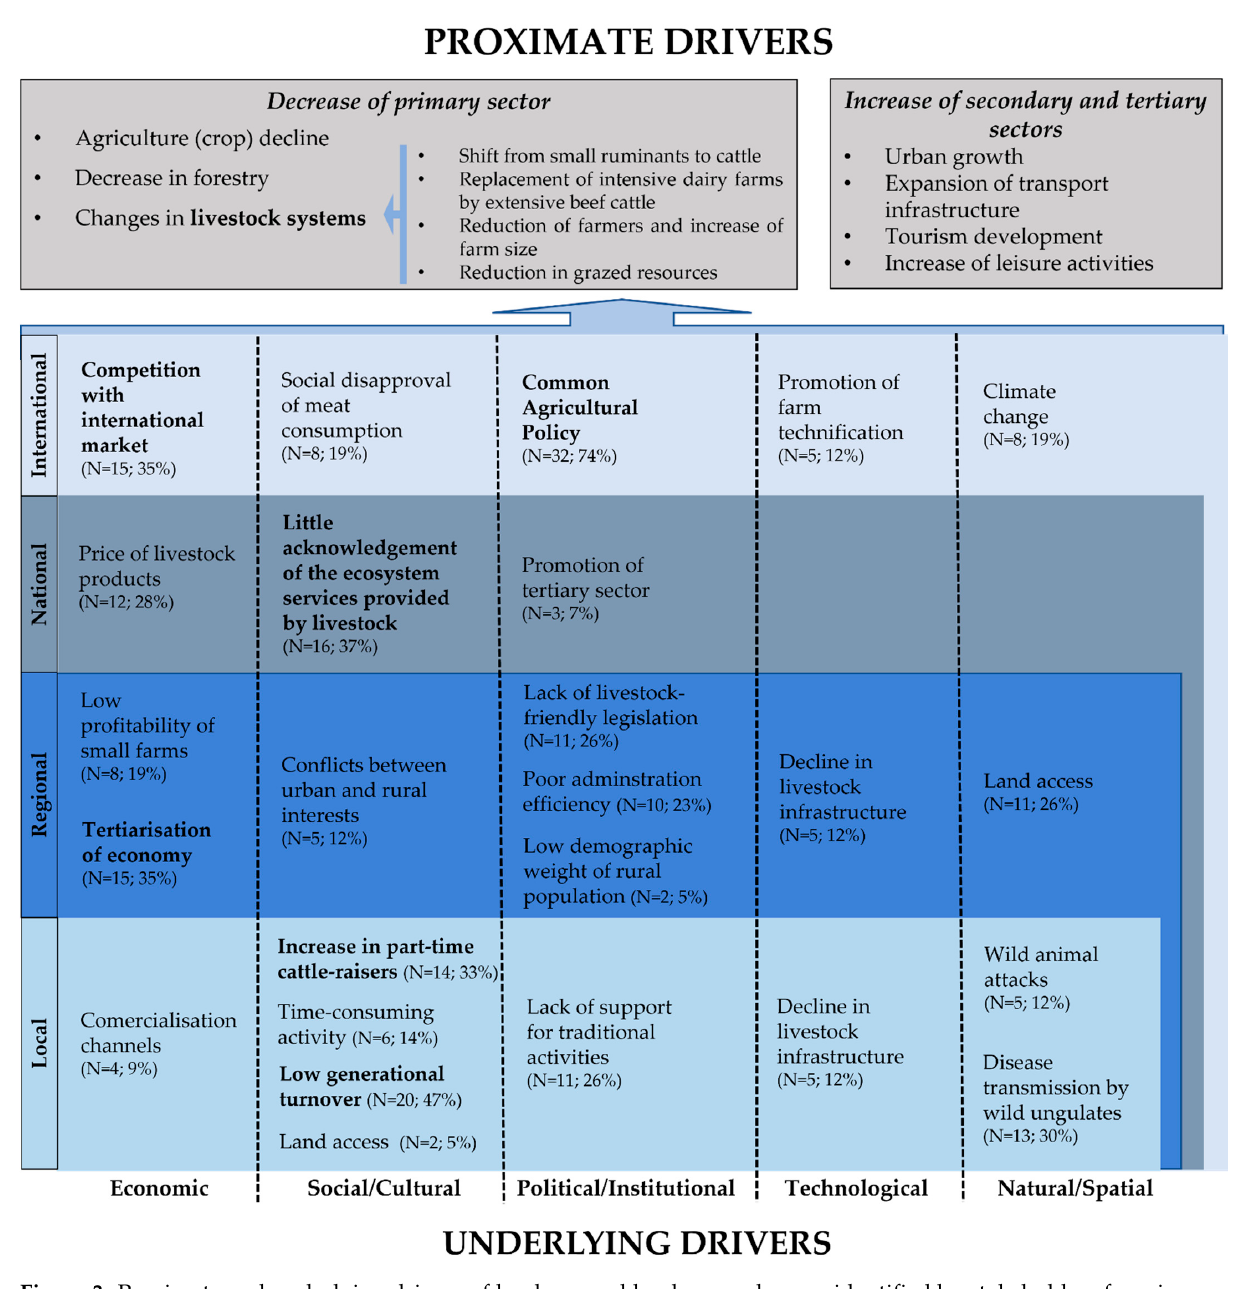
Figure 3. Proximate and underlying drivers of land use and land cover changes identified by stakeholders focusing on livestock-related factors in two study areas of Madrid region. The proximate drivers (top) identified by the stakeholders are shown according to the main topics. The underlying drivers (bottom) are adaptations of the topics mentioned by the interviewees, nested according to their scale of impact, and categorized by the typology suggested in [6]. The most frequently cited underlying drivers are highlighted in bold. Gaps of information are due to lack of mention by the interview- ees.